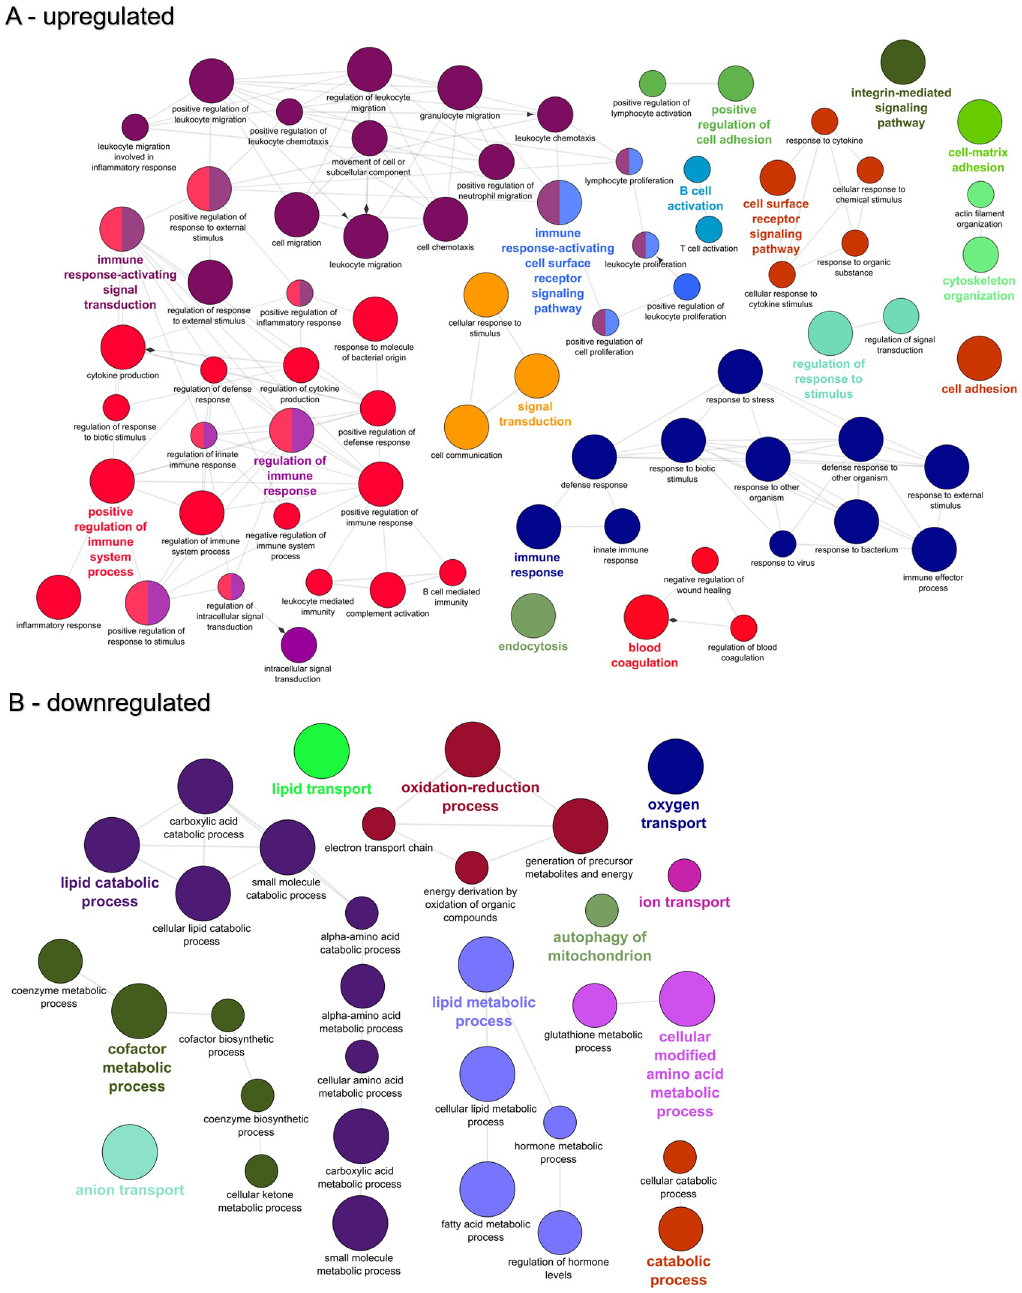
Fig 8. Functional enrichment of biological processes among the genes differentially expressed in the intestine of susceptible fish at 21 days post exposure to Ceratonova shasta . Enriched gene ontology (GO) terms were grouped into functionally related nodes using the Cytoscope plugin ClueGO. Nodes are colored and grouped according to a related function and labelled by the most significant term of the group. Node size corresponds to the FDR-adjusted p-value of each GO term and is specific to each graph. The analysis was conducted separately on upregulated (A) and downregulated (B) genes.